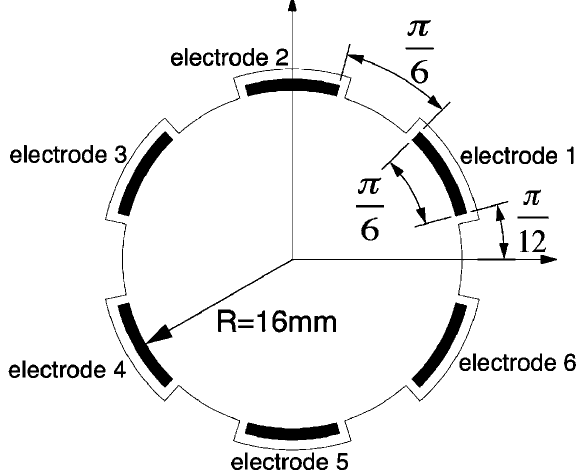
FIG. 6. Configuration of a specific six-electrode BPM with circular cross